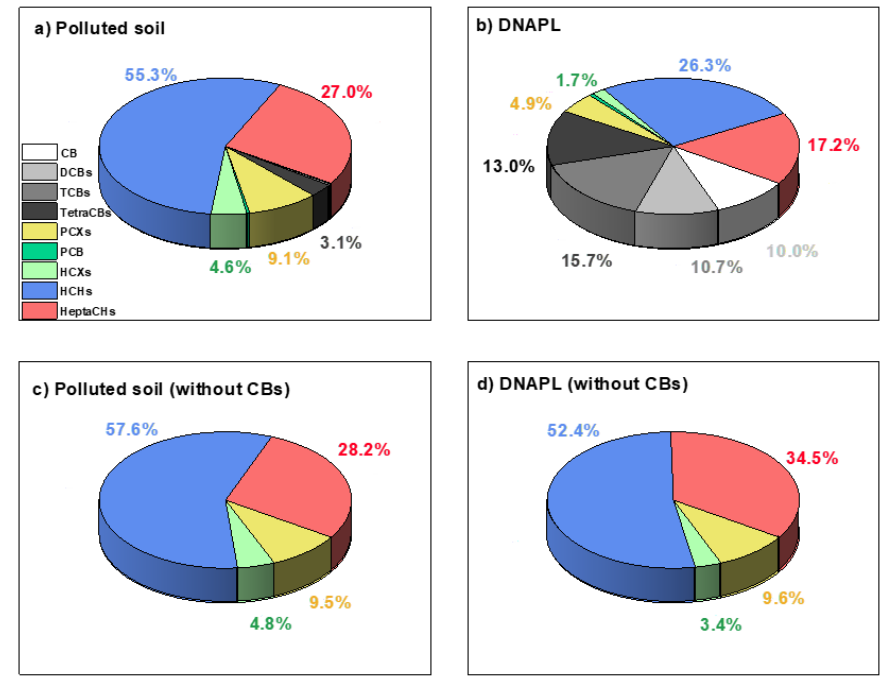
Figure 1. COCs distribution (grouped by families) in the polluted soil B2 (C COCs,0 = 3682 mg/kg) ( a ), DNAPL ( b ), polluted soil without CBs ( c ), and DNAPL without CBs ( d ) (mass percentages).